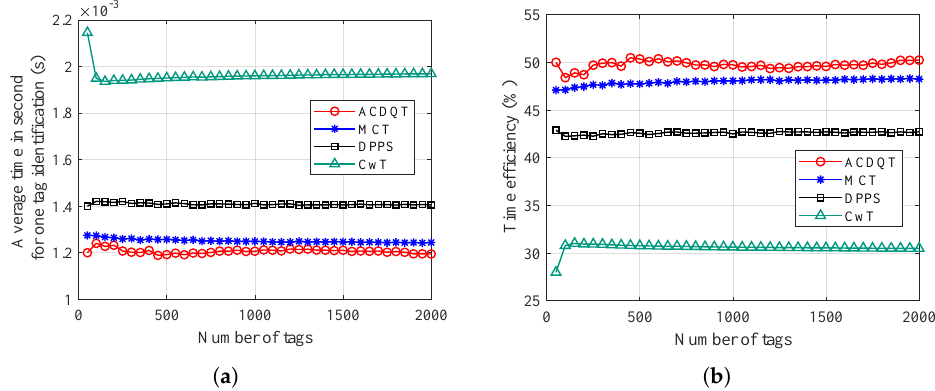
Figure 10. Time performance: ( a ) average time for one tag identification; ( b ) time